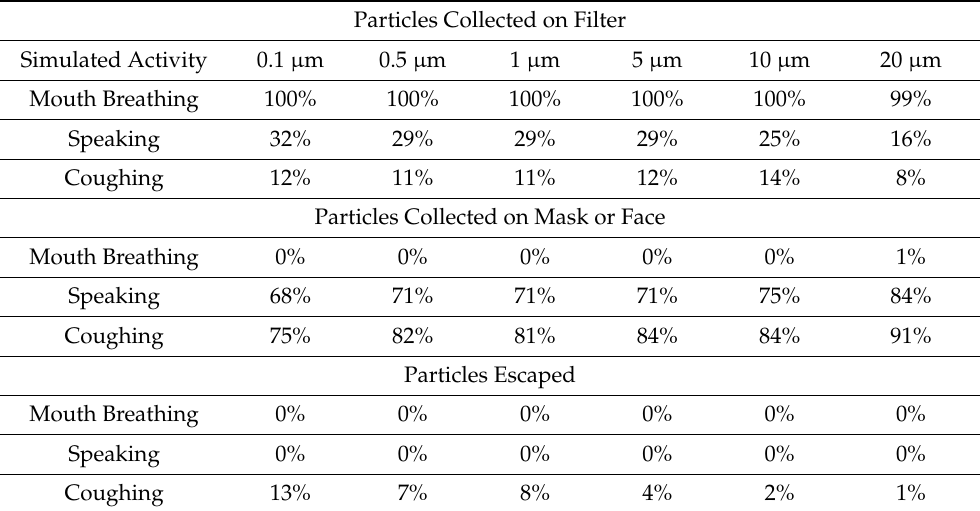
Table 3. Results of CFD modeling. Collection efficiencies are based on simulations using 100 particle